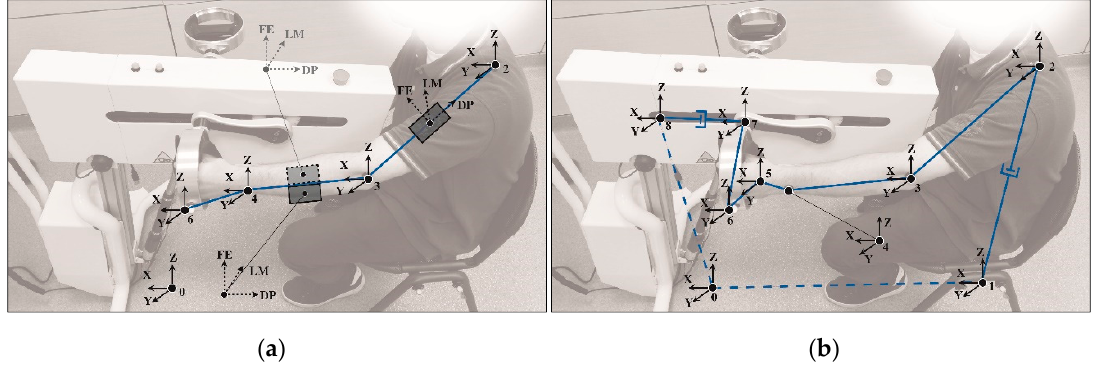
Figure 3. From the left, ( a ) the simplified kinematic model, and ( b ) the complete kinematic model.